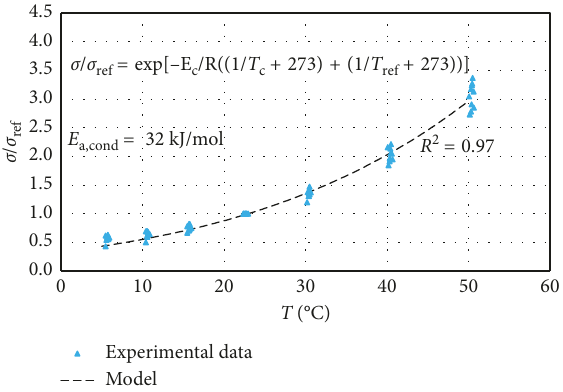
Figure 6: A single ATC for all tested mixtures based on E